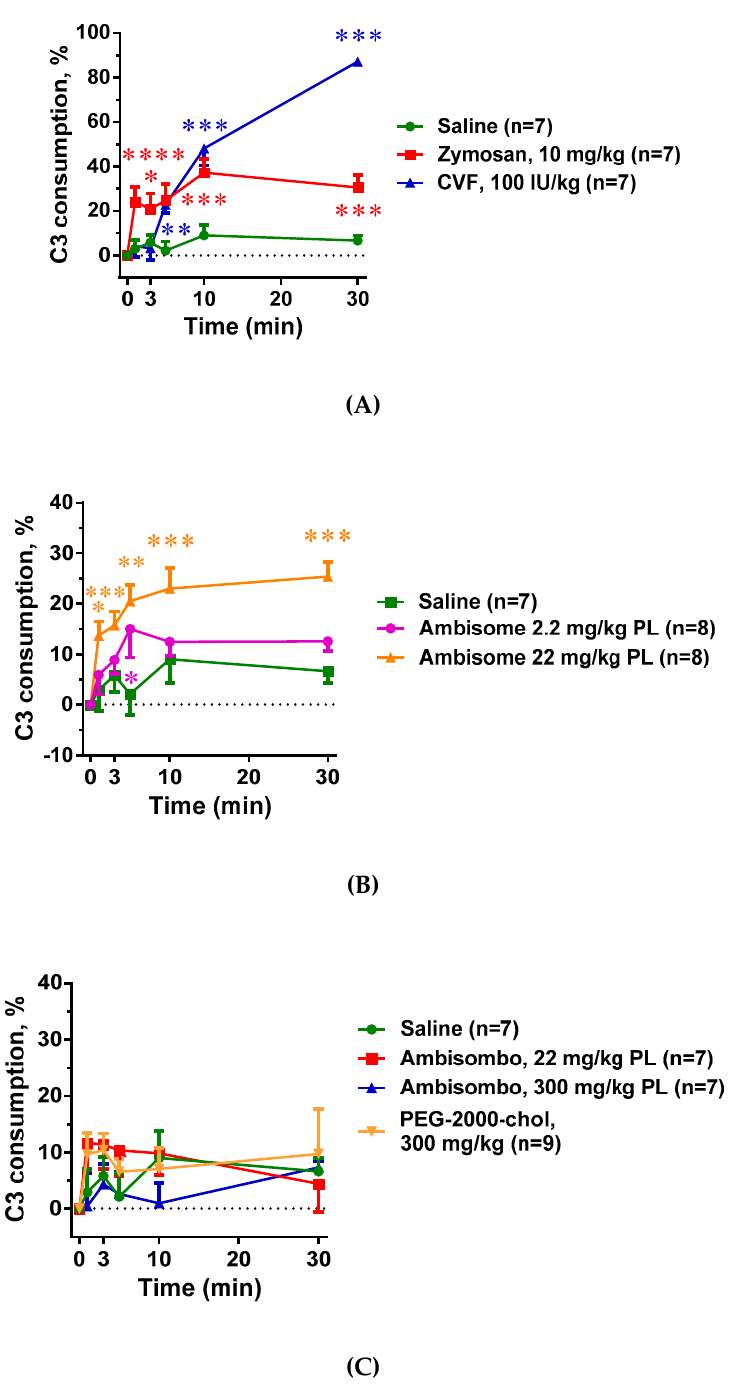
Figure 1. Effects of direct complement activators, amphotericin B-containing and empty liposomes, on the complement system in anesthetized rats. Complement activation was assessed as complement C3 consumption expressed as percentage decreases in C3 concentration relative to the baseline (time 0). ( A ) Effects of direct complement activators, zymosan and cobra venom factor (CVF); ( B ) Effects of the amphotericin B-containing liposome AmBisome applied at 2 different doses. ( C ) Effects of empty liposomes, AmBisombo and PEG-2000-chol. The data are mean ± SEM. Statistical analysis was performed using two-way repeated measurements ANOVA followed by Dunnett’s multiple comparisons post-hoc test. Significant differences (* = p < 0.05; ** = p < 0.01; *** = p < 0.001) are shown relative to the group treated with saline.